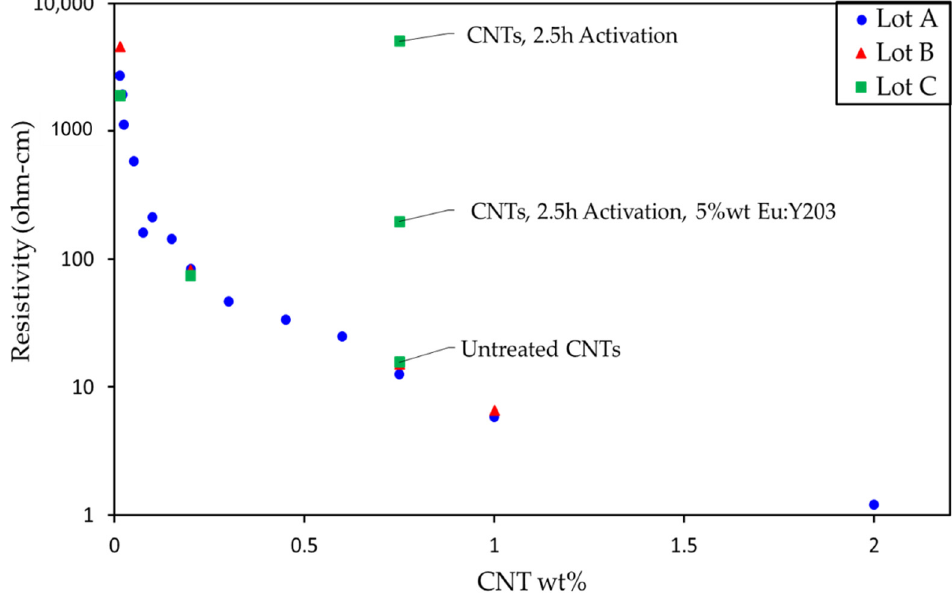
Figure 9. Measured electrical resistivity of current CNT pulp (Lot C) contrasted with past production runs (Lot A,B) with an applied current of 400 µA.